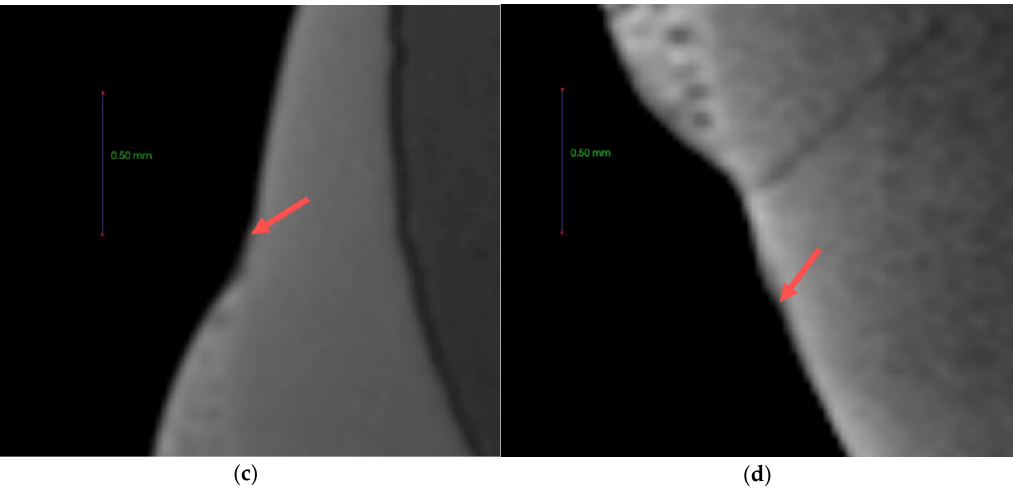
Figure 11. 87% gray value point from the reference point of the LV and FBAG orthodontic bonding adhesive via micro-CT. ( a ) LV; ( b ) FBAG1; ( c ) FBAG3; ( d ) FBAG5.